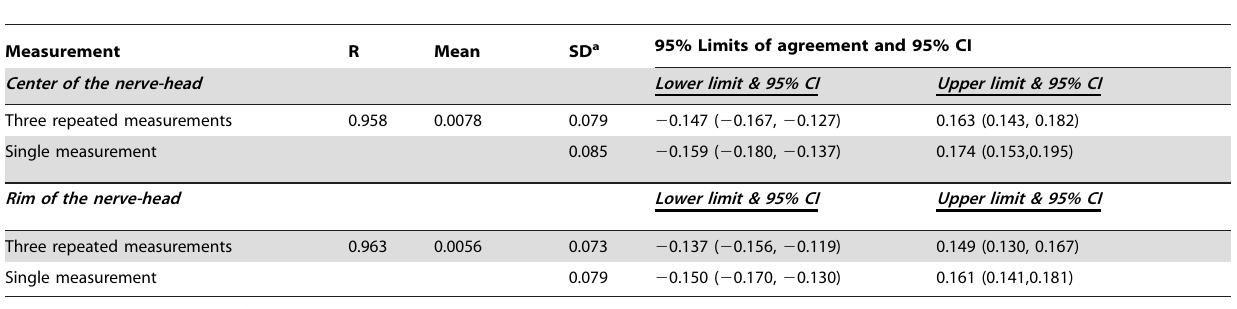
Table 2. Pearson’s correlation coefficient R and agreement measurements for nerve-head fovea distances in left and right eyes.